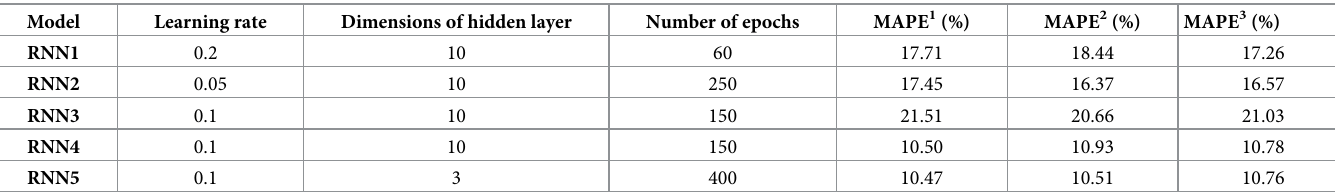
Table 7. Training results of RNN1-RNN5 models. Model